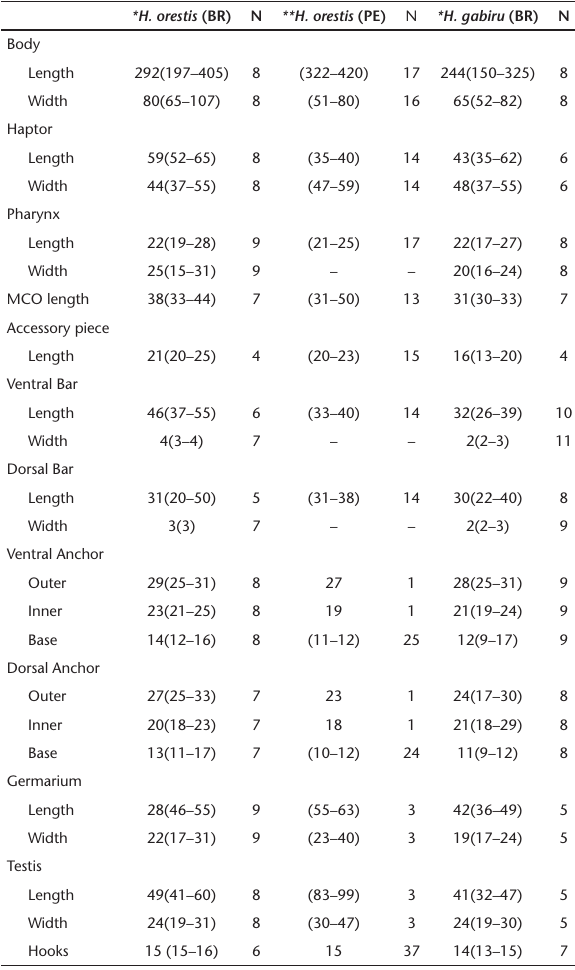
Table 6. Comparative measurements (μm) of specimens of Cosmeto- cleithrum bifurcum from the gills of Hassar orestis and H. gabiru from Brazil and H. orestis from Peru. BR = Brazil, PE =